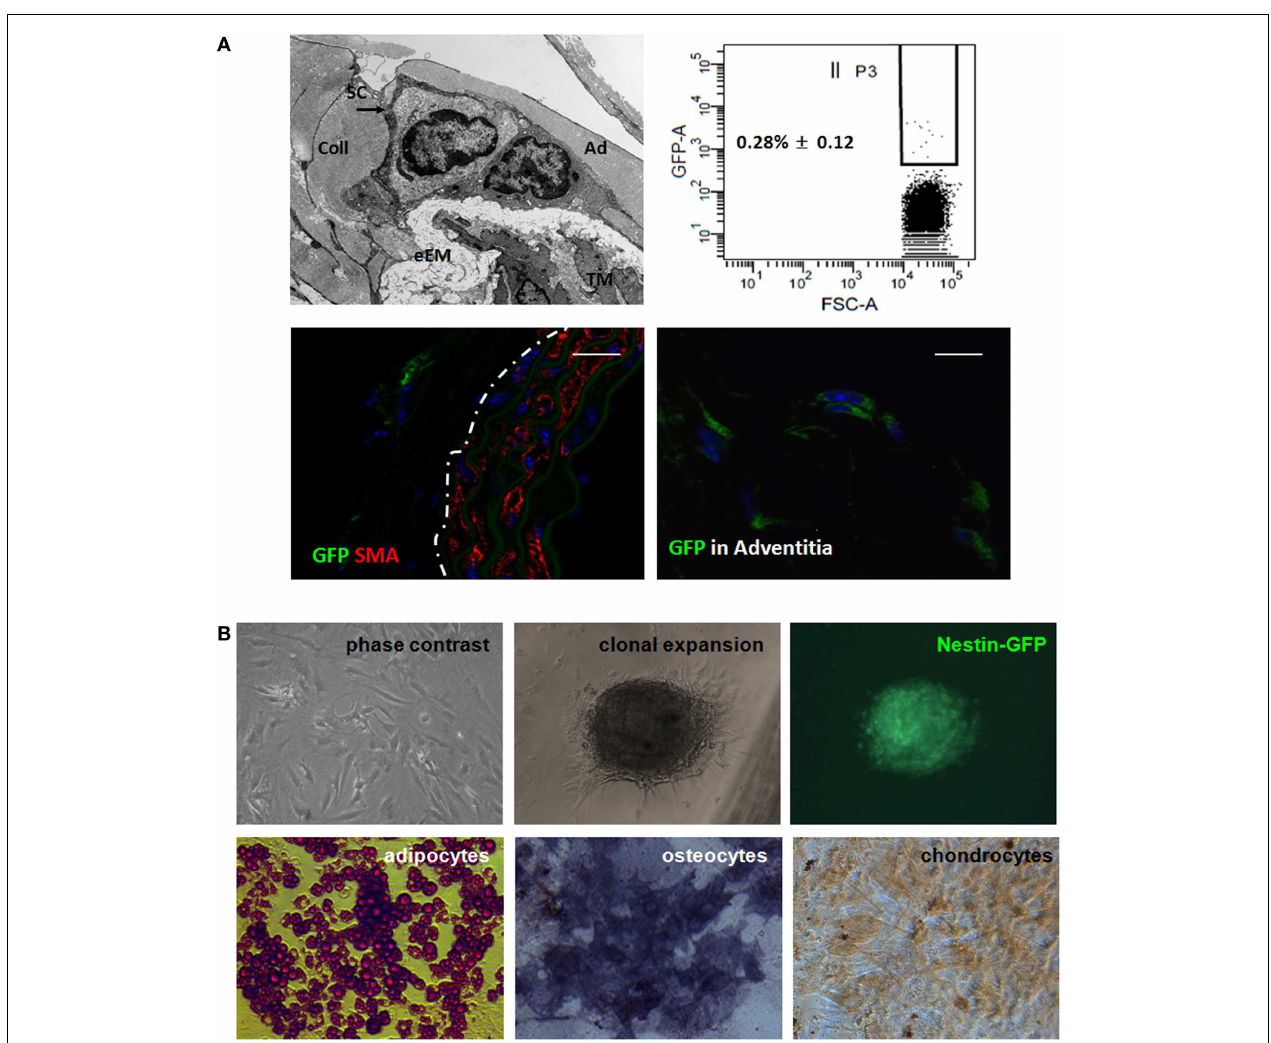
combining antibodies against GFP (green) and SMA (red). Dotted line marks the border between media and adventitia of the aorta wall. Scale bar 20 µ m. (B) Verification of trilineage differentiation. Clonally expanded Nest-GFP( + ) were subjected to in vitro differentiation into adipocytes, chondrocytes, and osteocytes. Differentiation was observed within 14days after induction of differentiation as shown by Oil red staining, by immunostaining for collagen type II (Coll II) and by histochemical staining for alkaline phosphatase (ALP). Magnification 620 ×